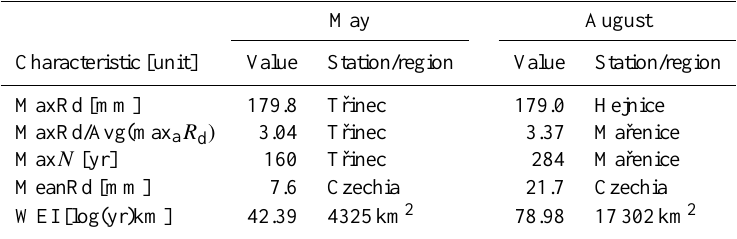
Table 1. Comparison of reference events by characteristics discussed in Sect. 2 and by the WEI: maximum daily precipitation total at a site (Max R d ) , maximum ratio of Max R d to the average annual maximum daily total at a site (Max R d / Avg[max a R d ]), maximum return period of a daily precipitation total at a site (Max N ), maximum mean daily precipitation total within the Czech Republic (Mean R d ) , and weather extremity index (WEI). The values only represent the territory of the Czech Republic. May August Characteristic [unit] Value Station/region Value Station/region MaxRd [mm] 179.8 Tˇrinec 179.0 Hejnice MaxRd/Avg(max a R d ) 3.04 Tˇrinec 3.37 Maˇrenice Max N [yr] 160 Tˇrinec 284 Maˇrenice MeanRd [mm] 7.6 Czechia 21.7 Czechia WEI [log(yr)km] 42.39 4325km 2 78.98 17302km